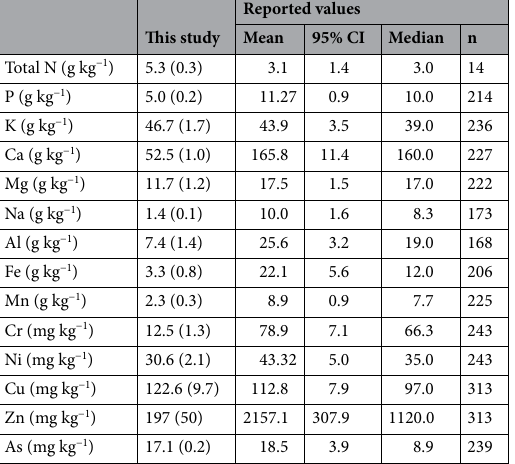
Table 5. Element concentration in wood ash used in this study and that from reported values given as mean, a 95% confidence interval (CI), and median. Cd and Pb were not detected in wood ash used in this study. Standard errors are shown in parentheses (n = 3). Mean, a 95% confidence interval, and median of reported values were calculated using the data of wood and/or bark fuel type ash in Wood Ash Database (http:// wooda sh. slu.